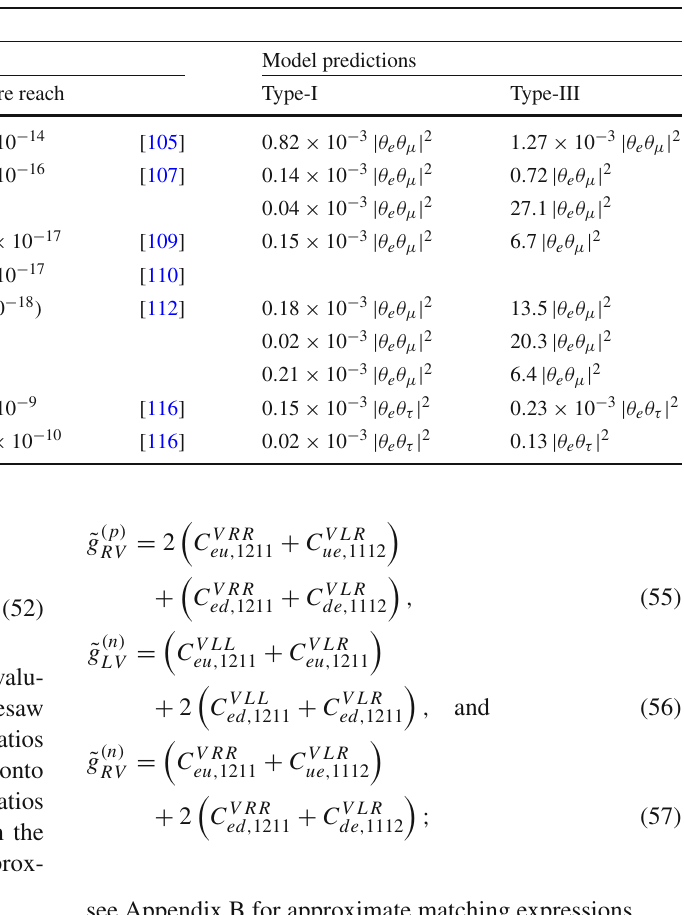
Table 7 Current and projected constraints on the LFV observables taken into account in this work, together with the pertinent model pre- dictions. The current bounds hold at 90% C.L. The future reach listed for BR (μ → 3 e ) refers to Phase II of the Mu3e experiment; an initial sensitivity of BR (μ → 3 e ) (cid:2) 2 × 10 − 15 is expected after Phase I. The